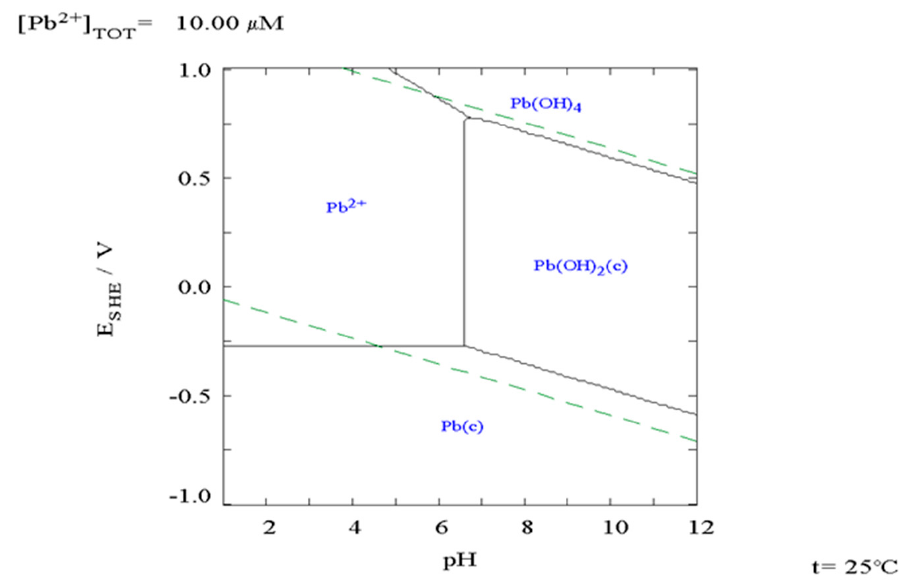
Figure 5. The Pourbaix diagram of lead in water [61].